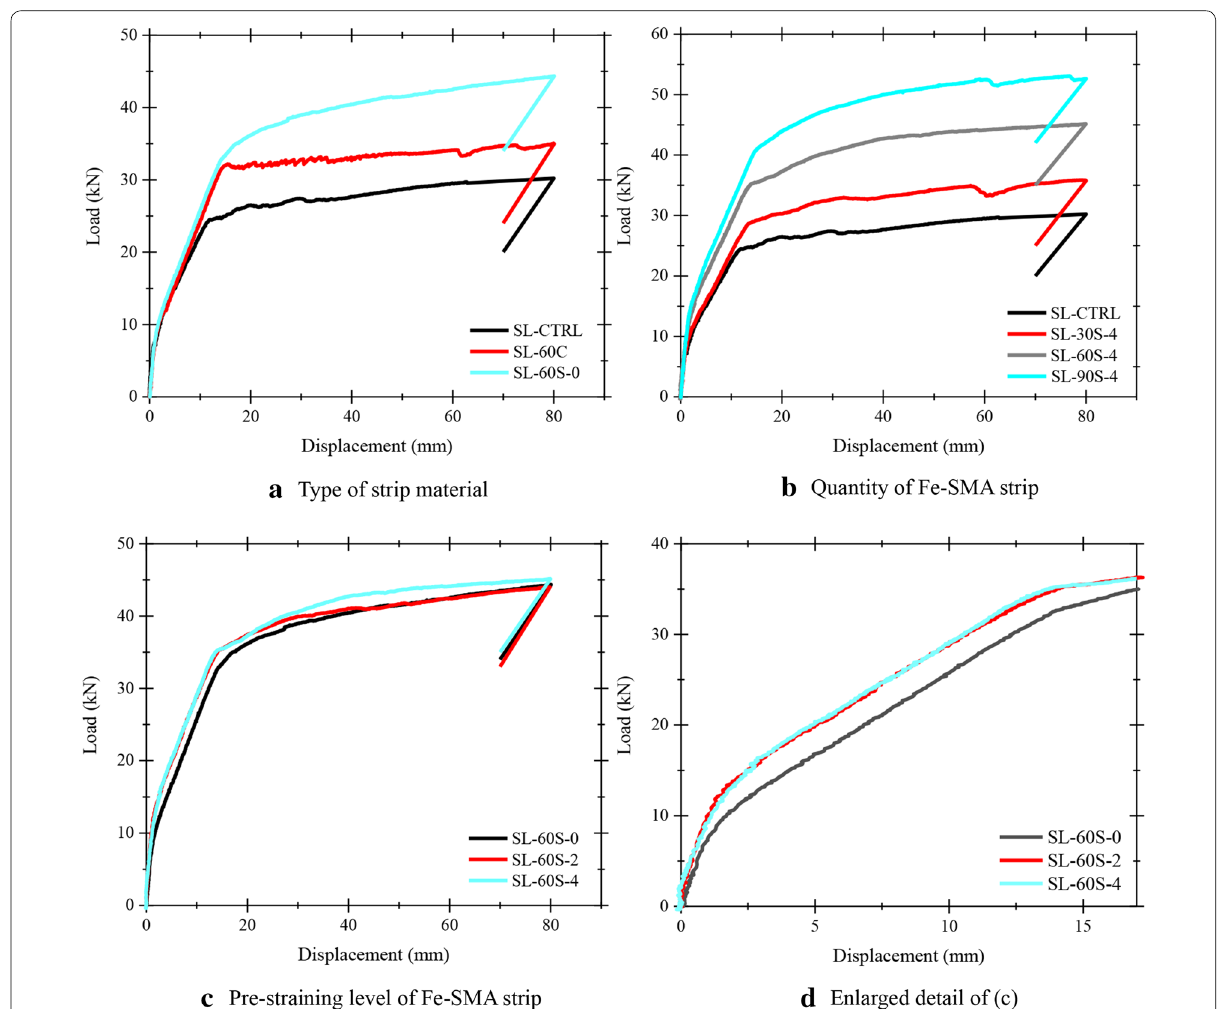
Fig. 13 Comparison of load–displacement